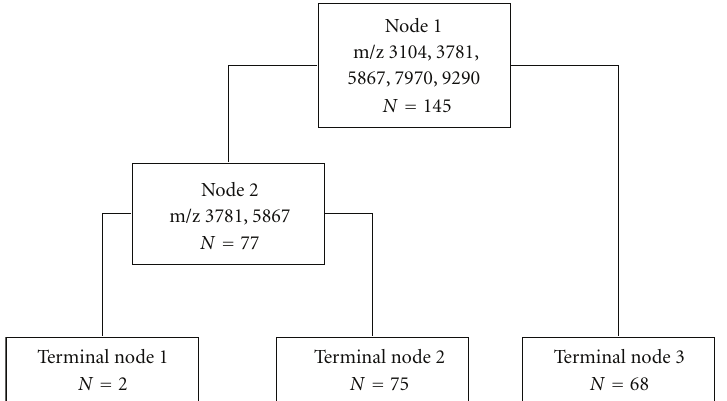
Figure 2: The pattern-matching algorithm to distinguish node-positive CRC patients from node-negative CRC patients on learning mode of training set. The left branch node after Node 1 is the cases of the linear combination: − 0.075 (m/z 3,104) − 0.231 (m/z 3,781) + 0.157 (m/z 5,867) + 0.086 (m/z 7,970) + 0.953 (m/z 9,290) ≤ 1.122, and the right one is > 1.122. The left branch node after the Node 2 is the linear combination: 0.410 (m/z 3,781) − 0.912 (m/z 5,867) ≤ 0.248, and the right one is > 0.248. The cases met to the conditions of Terminal Node 1 and Terminal Node 3 were diagnosed as node-positive CRC patients, and those met to the conditions of Terminal Node 2 were diagnosed as node-negative CRC patients. N represents the number of samples. m/z represents the mass to charge ratio. Table 1: SELDI protein peak intensities in serum with significant di ff erences ( P < 0 . 05) between node-positive CRC patients and node- negative CRC patients.